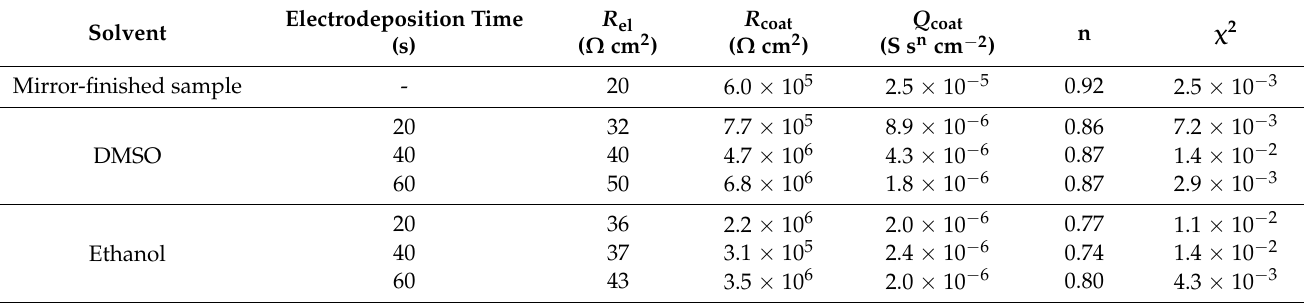
Table 1. Fitting parameters related to EIS spectra reported in Figure 6a,b. In the case of the mirror-finished sample, the resistance and the CPE are R ox and Q ox , respectively.